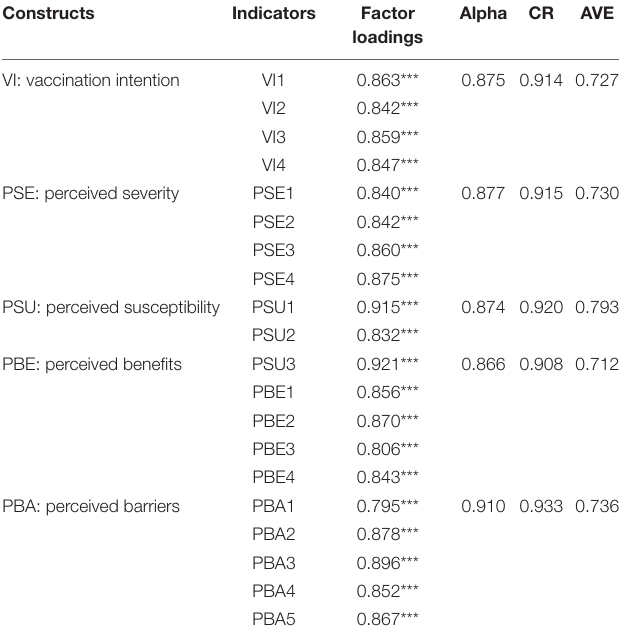
TABLE 3 | Correlation matrix of the reflective constructs.